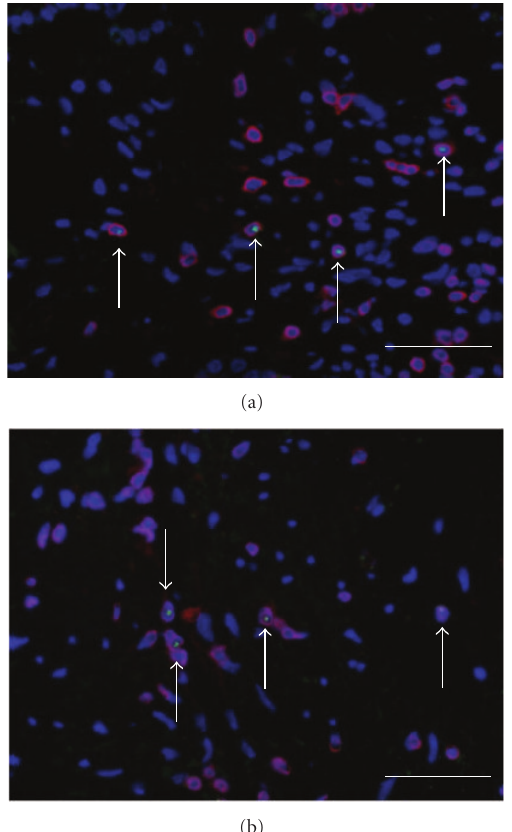
Figure 2: Identification of the cells expressing T-bet and GATA-3 protein in human nasal mucosa. (a) The dual staining for CD3 (red) and T-bet (green) in allergic nasal mucosa. The arrows indicate the cell expressing T-bet in nucleus of CD3 positive cells. (b) The dual staining for CD3 (red) and GATA-3 (green) in allergic nasal mucosa. The arrows indicate the cell expressing GATA-3 in nucleus of CD3 positive cells. Scale bar = 100 μ m.